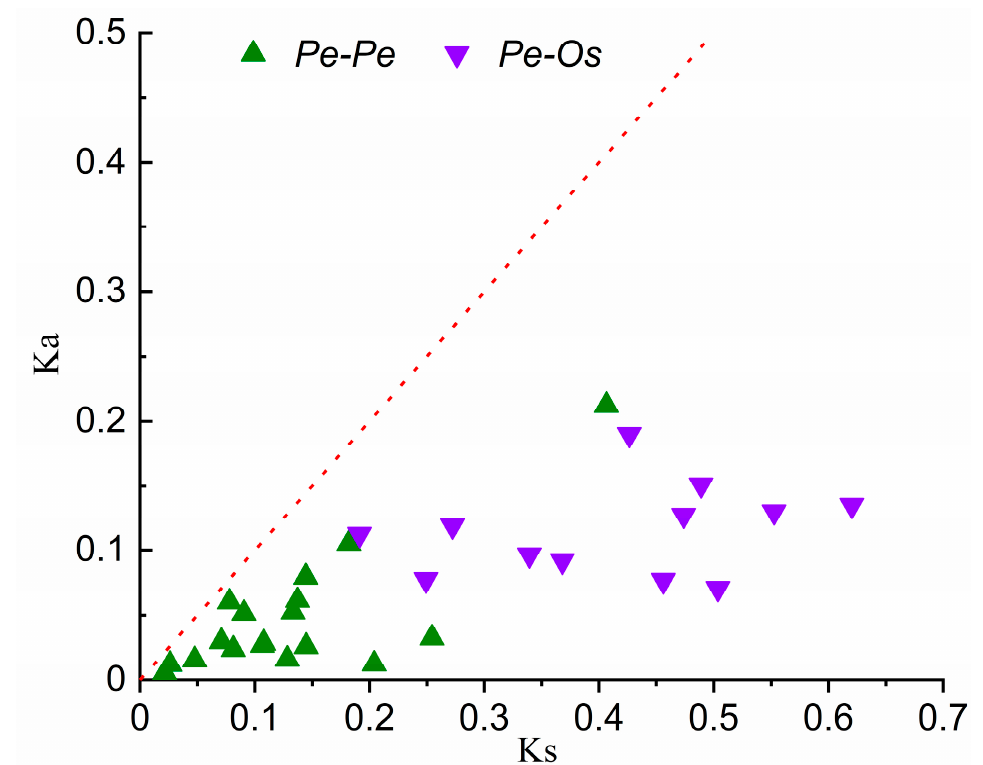
Figure 7. Distribution of Ka and Ks from paralogous ( Pe–Pe ) and orthologous ( Pe–Os ) gene pairs. Twelve putative orthologous gene pairs ( Pe–Os ) and nineteen putative paralogous gene pairs ( Pe–Pe ) are displayed in different colors and shapes, and the red dashed line indicates the slope of Ka/Ks = 1. Table 3. Orthologous ( Pe–Os ) and paralogous ( Pe–Pe ) expansin gene pairs.